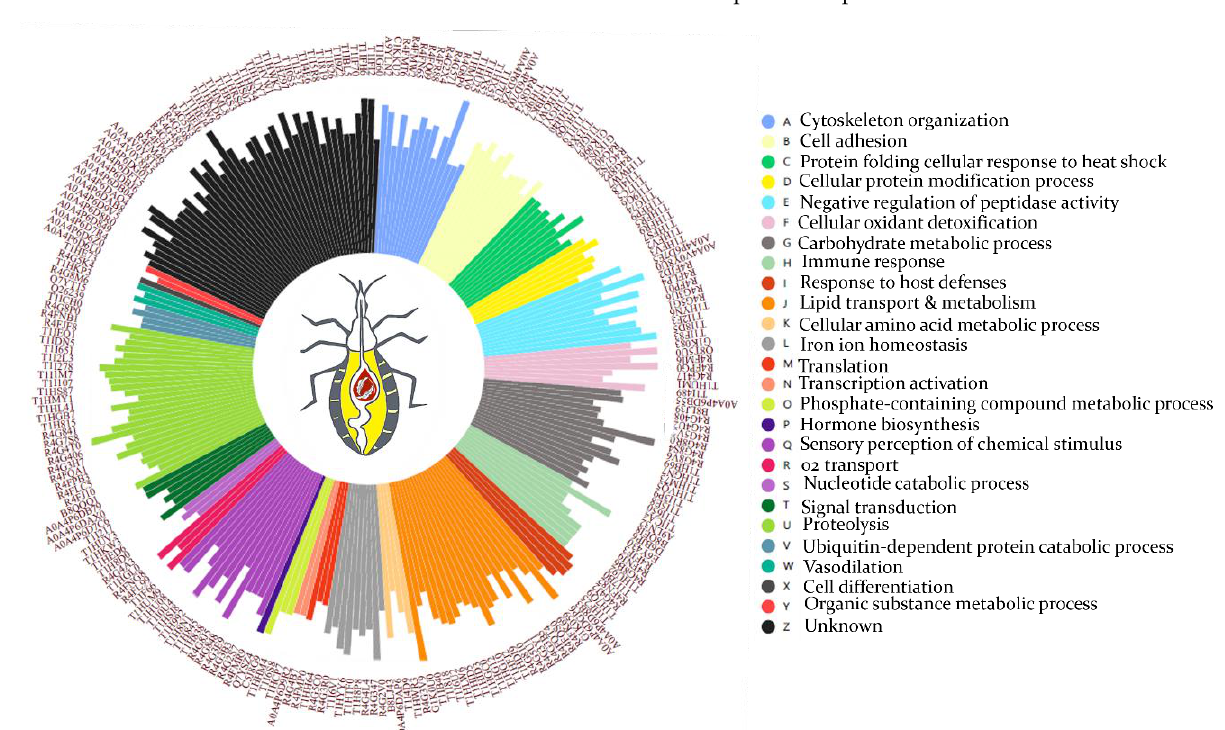
Figure 3. Circular histogram illustrating the distribution of R. prolixus secreted hemolymph proteins. The height of each bar is proportional to the LFQ intensity of expression of the corresponding protein, and each bar is related to the protein’s UniProt ID. Protein categories in the right panel are listed from the histogram clockwise.